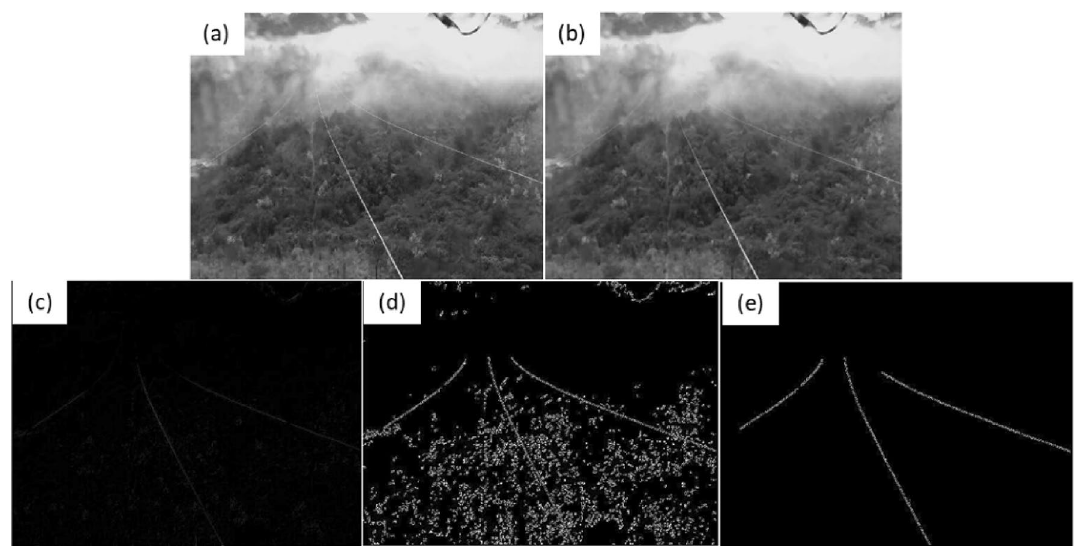
Fig. 4 a Grayscale image of the original image, b filtered image, c enhanced image, d edge contour map of the enhanced image, e filtered